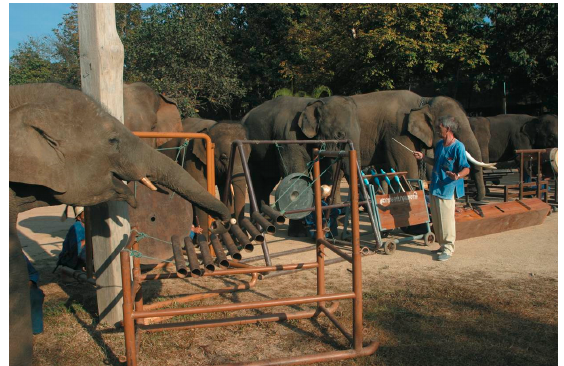
Figure 4. The Thai Elephant Orchestra [43].